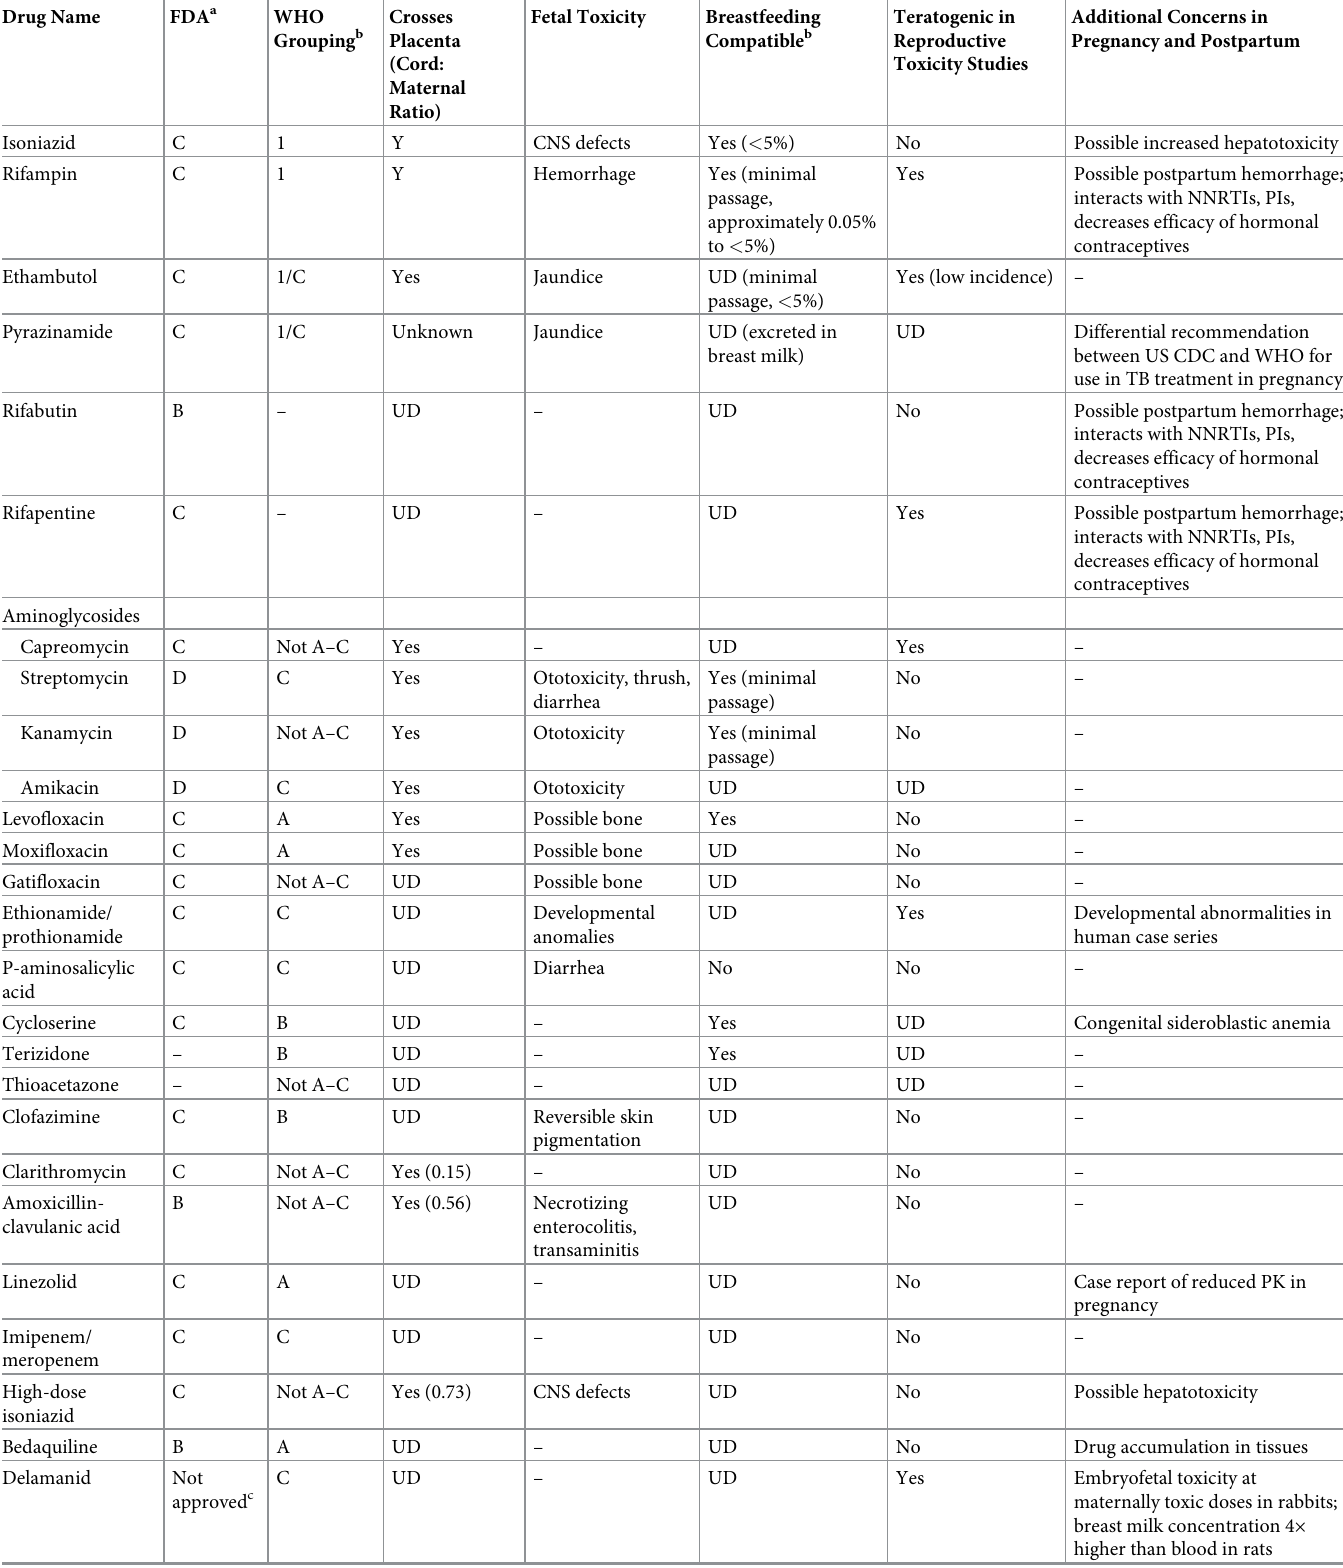
Table 1. FDA/WHO pregnancy classification and select maternal–fetal and reproductive toxicity characteristics of drugs used to treat